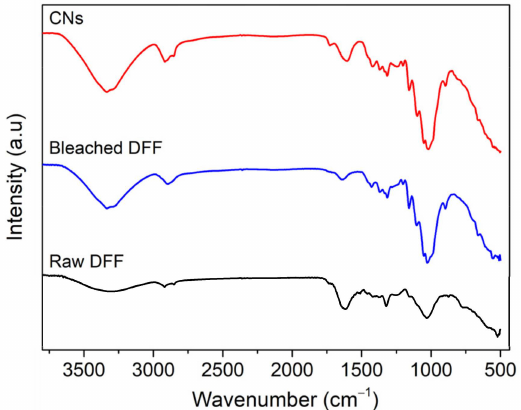
Figure 3. Fourier transform infrared spectra of raw DFF ( black ), bleached DFF ( blue ) and CNs ( red